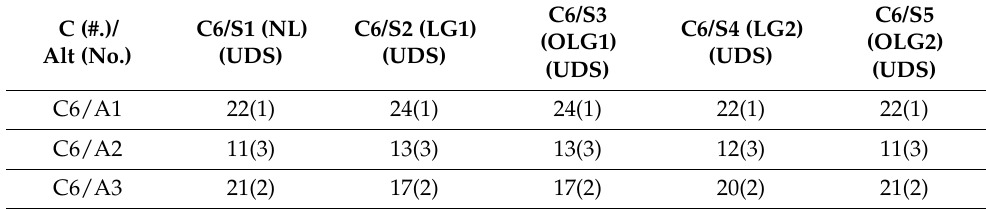
Table 28. MCDM evaluations analysis in Case 6 (C4/S1–S5) in terms of UDS for the 75-bus MCMG.